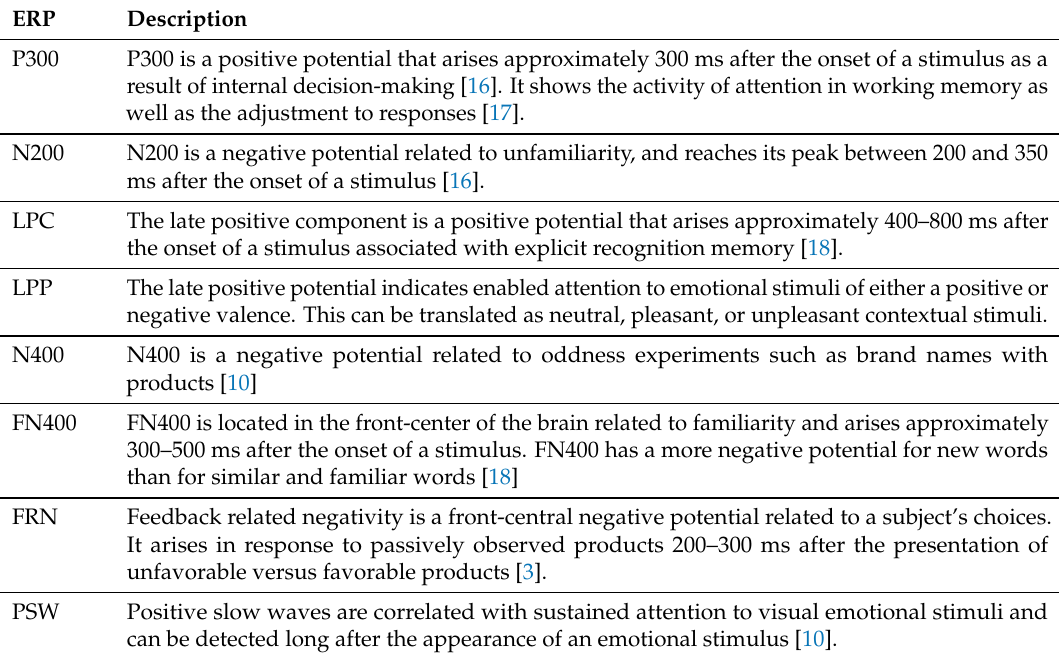
Table 2. Common ERP components used in neuromarketing